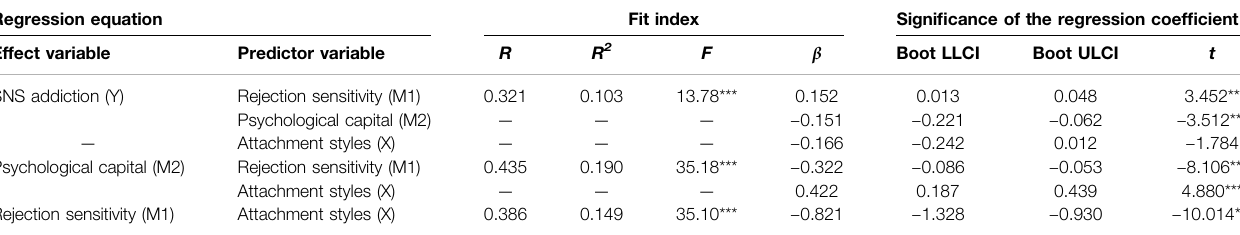
TABLE 2 | Analysis of multiple mediating effects of rejection sensitivity and psychological capital with demographic variables as covariates. Regression equation